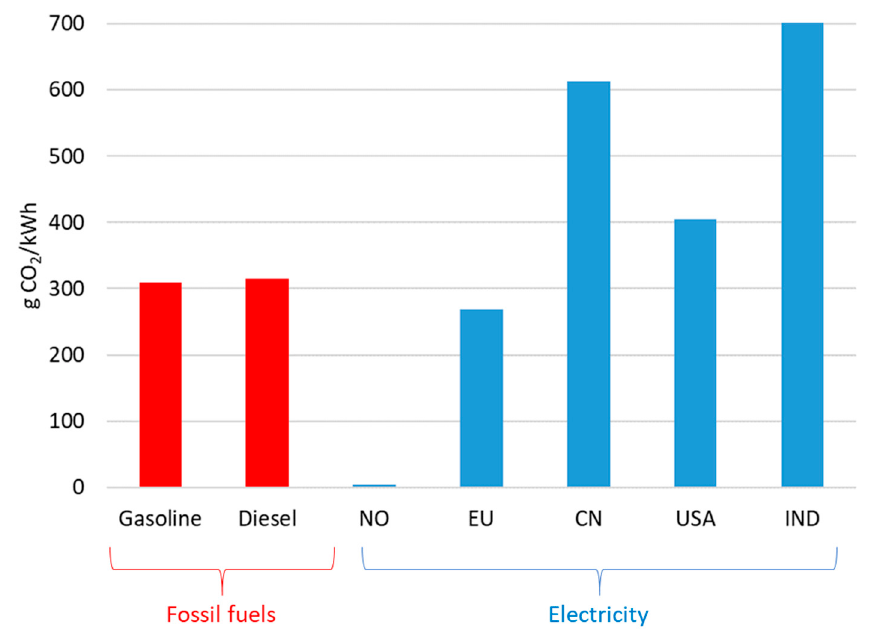
Figure 17. Specific CO 2 emissions of electricity generated in various countries compared to gasoline and diesel.